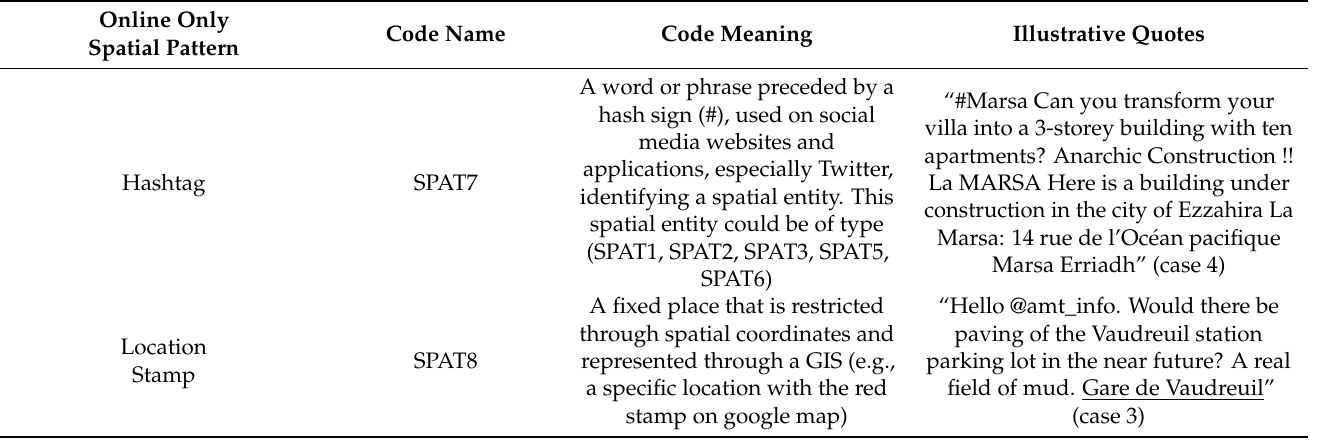
Table A5. Spatial patterns in SP data online